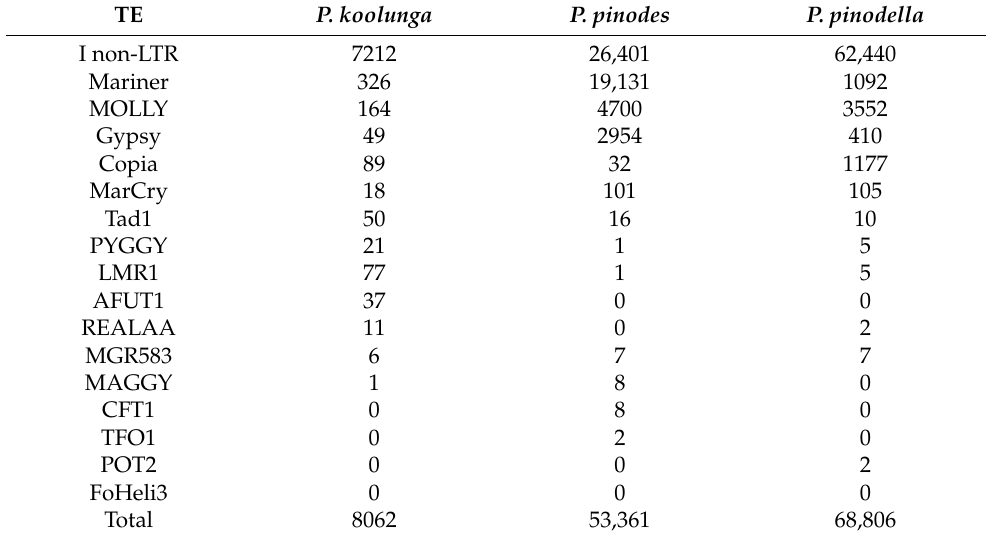
Table 3. Read count of the expressed TE in AB